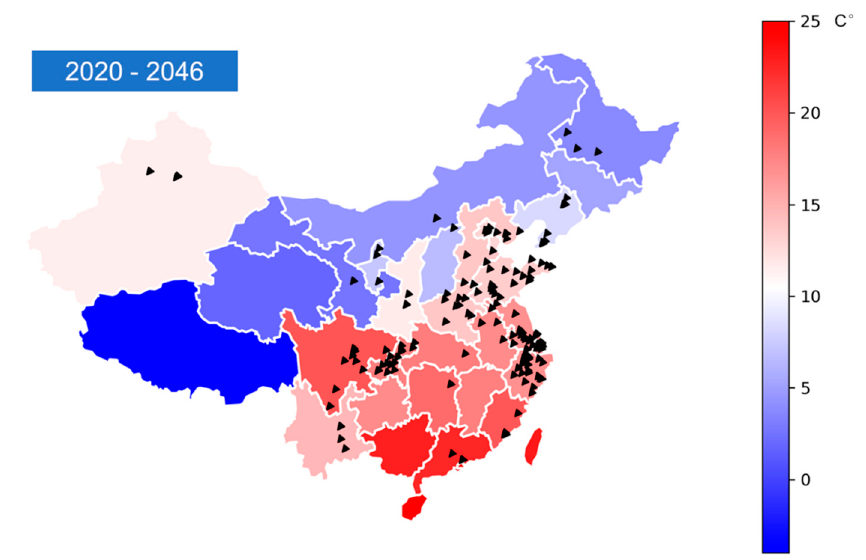
Figure A2. Annual average temperature levels in short-term future (2020–2046), and locations of wastewater treatment plants included in the sample.